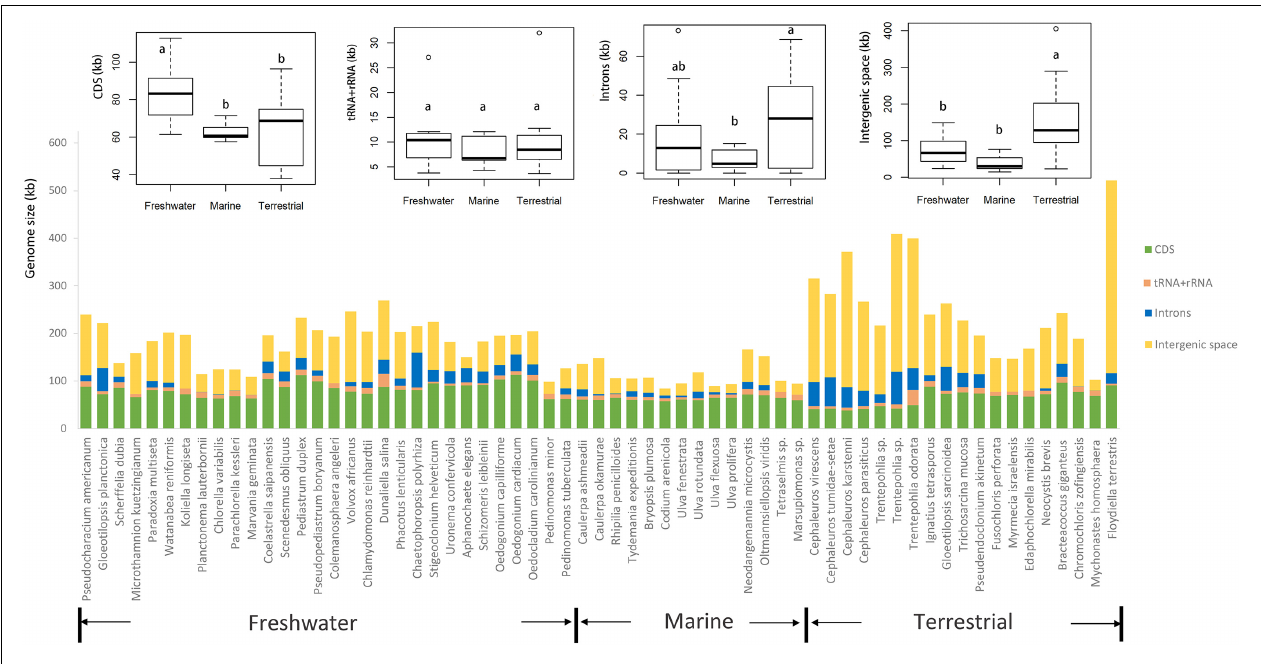
FIGURE 4 | Comparison of chloroplast genome size ordered by habitat (freshwater, marine, and terrestrial). Comparison of CDS, tRNA + rRNA, introns, and intergenic region from freshwater, marine and terrestrial habitats was shown on the top of the graph. The common letters above boxplots represent insignificant differences of variables (e.g., a and ab; ab and b), the different letters above boxplots represent significant differences variables (e.g., a and b; b and